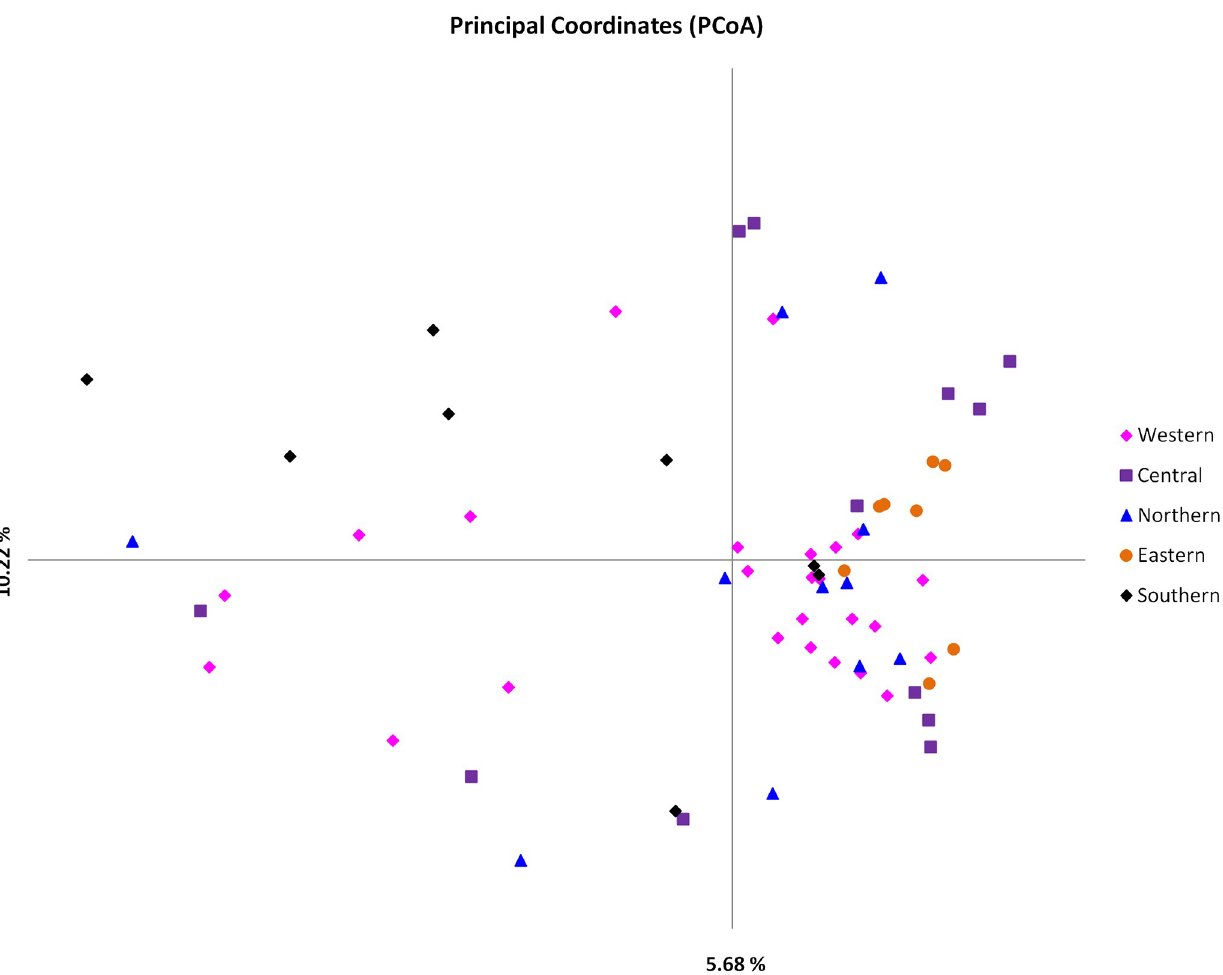
Fig 9. Principal component analysis (PCA) of field samples from different regions of Burundi. The samples are occupying all quadrants of the PCA and exhibiting low genetic differentiation across the different regions. The variation in proportion in the population data set given on each axis.